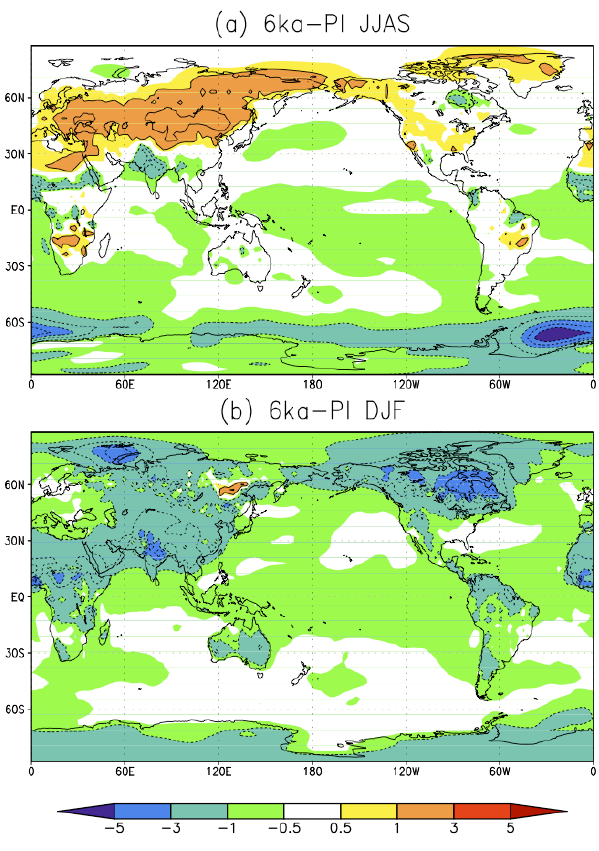
Fig. 8. The change in precipitation 6ka PI (mmday − 1 ) for (a) JJAS and (b) DJF. Figure 8. The change in precipitation 6ka-PI (mm/day) for (a) JJAS and (b) DJF. 3 4